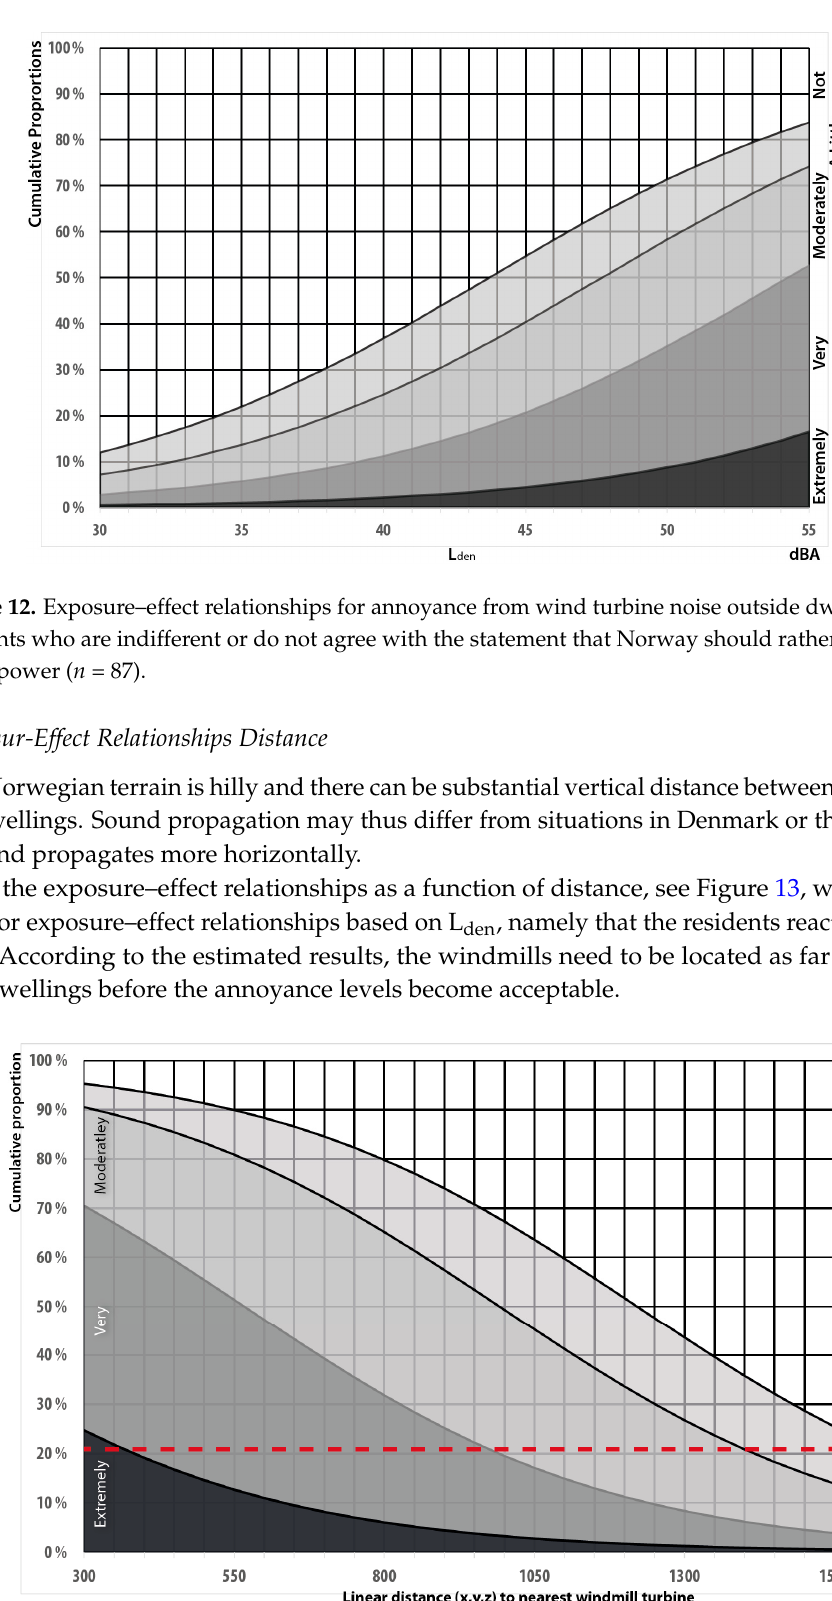
Figure 12. Exposure–effect relationships for annoyance from wind turbine noise outside dwellings for residents who are indifferent or do not agree with the statement that Norway should rather prioritize hydropower ( n = 87).